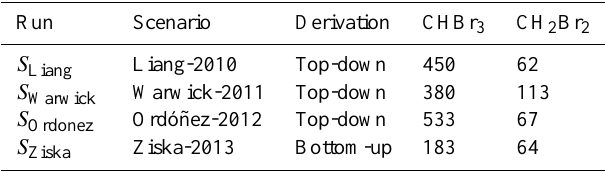
Table 1. Summary of 14yr CTM runs and the global total source strength (Gg source gas yr − 1 ) of CHBr 3 and CH 2 Br 2